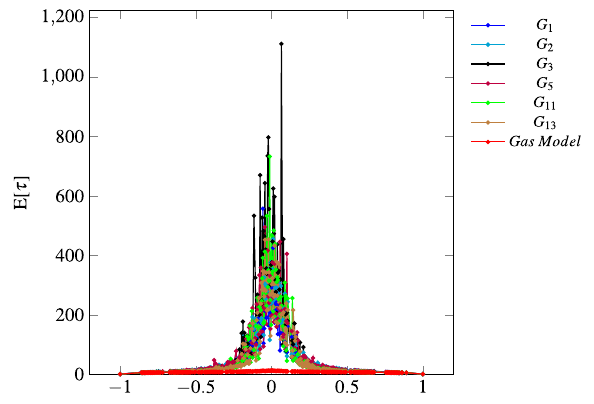
Figure 13. Convergence time, 21 × 21 Toruses, Grids G 1 , G 2 , G 3 , G 5 , G 11 and G 13 and the Gas Model k = 2 , 3,